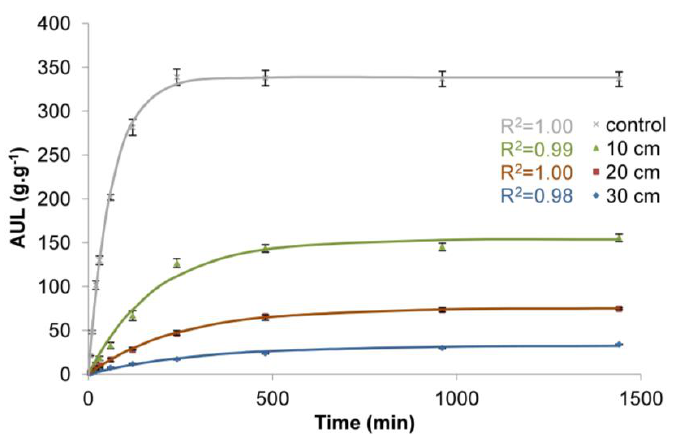
Figure 5. Time dependence of the AUL values for superabsorbent polymer loaded with soil of a bulk density of 0.9 g∙cm −3 and 10, 20, and 30 cm deep soil layers.